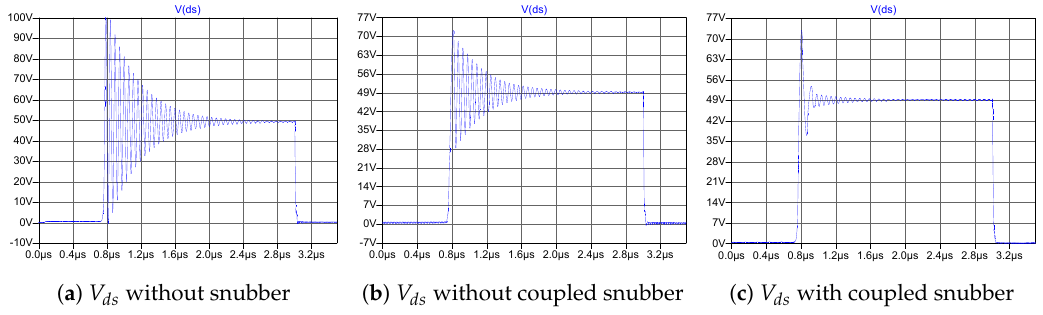
Figure 9. Simulation results for the voltage across the MOSFET switch “ V in = 24 V”.